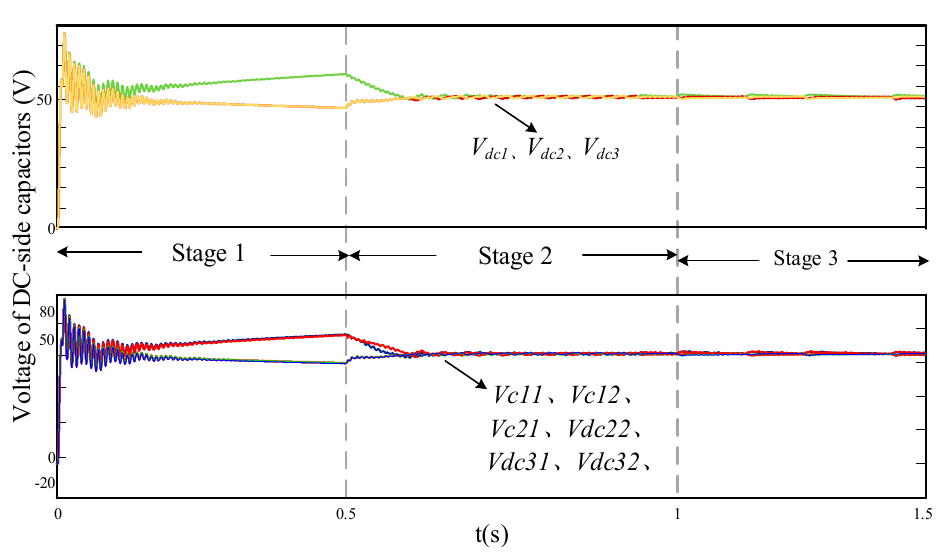
Figure 9. The waveform of capacitors’ voltage on DC-link.